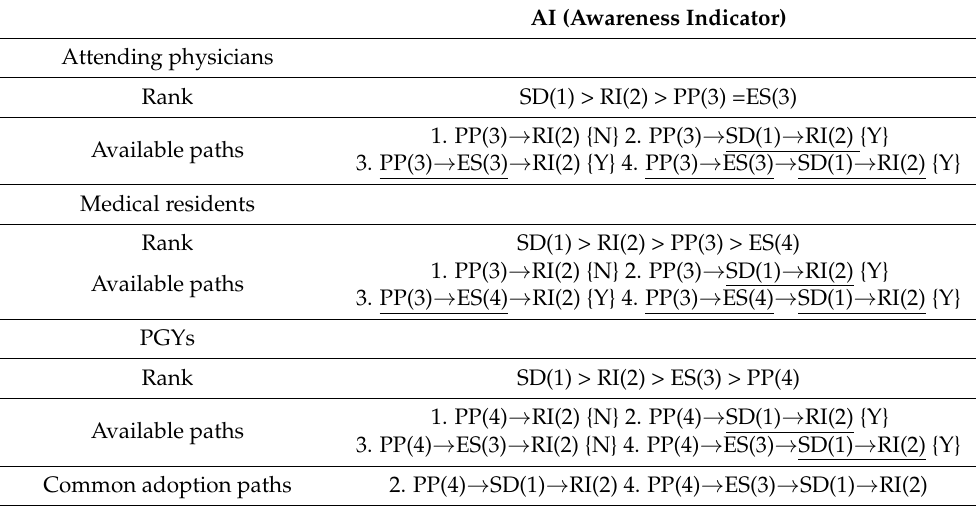
Table 13. Common adoption paths for AI (awareness